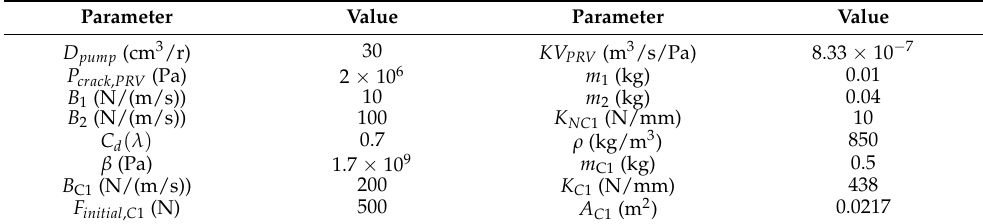
Table 3. Parameters used in simulation of the hydraulic actuation